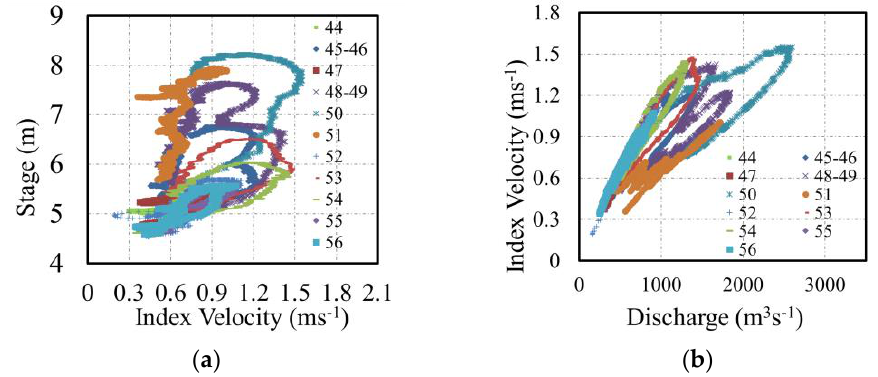
Figure 5. Hysteretic relationships between variable pairs for the Water Year 2017: ( a ) stage vs. index velocity; and ( b ) index velocity vs. discharge.